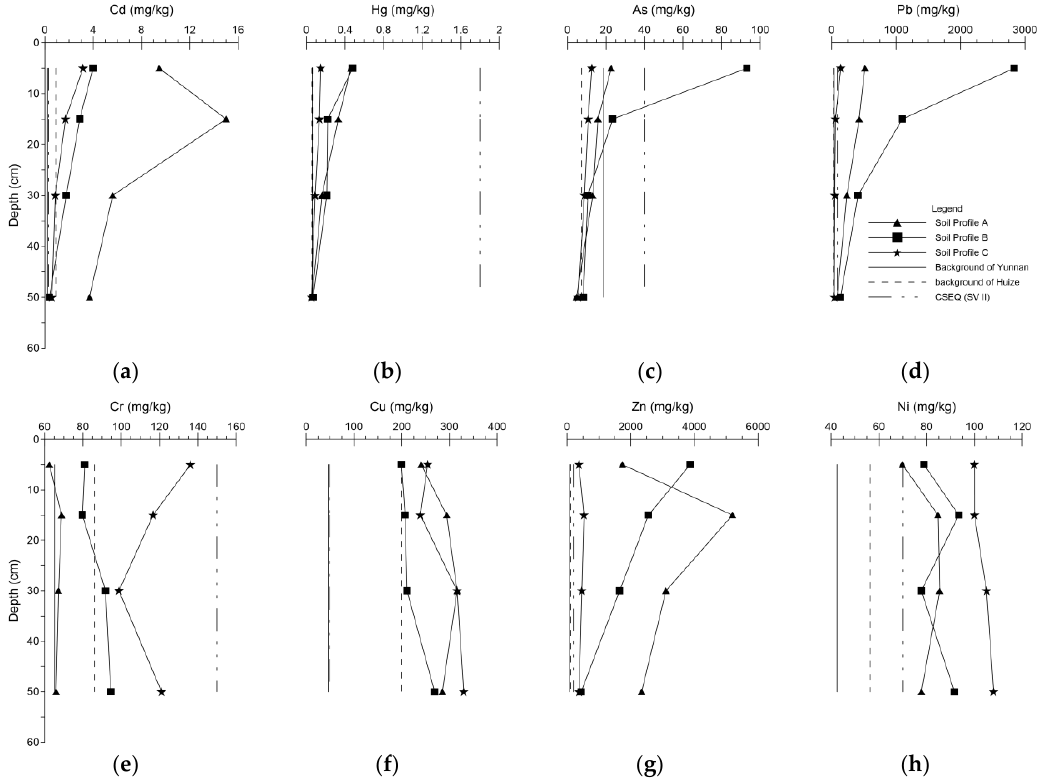
Figure 4. Vertical distribution of metal concentrations of Cd ( a ), Hg ( b ), As ( c ), Pb ( d ), Cr ( e ), Cu ( f ), Zn ( g ) and Ni ( h ) of Profile A, B and C.